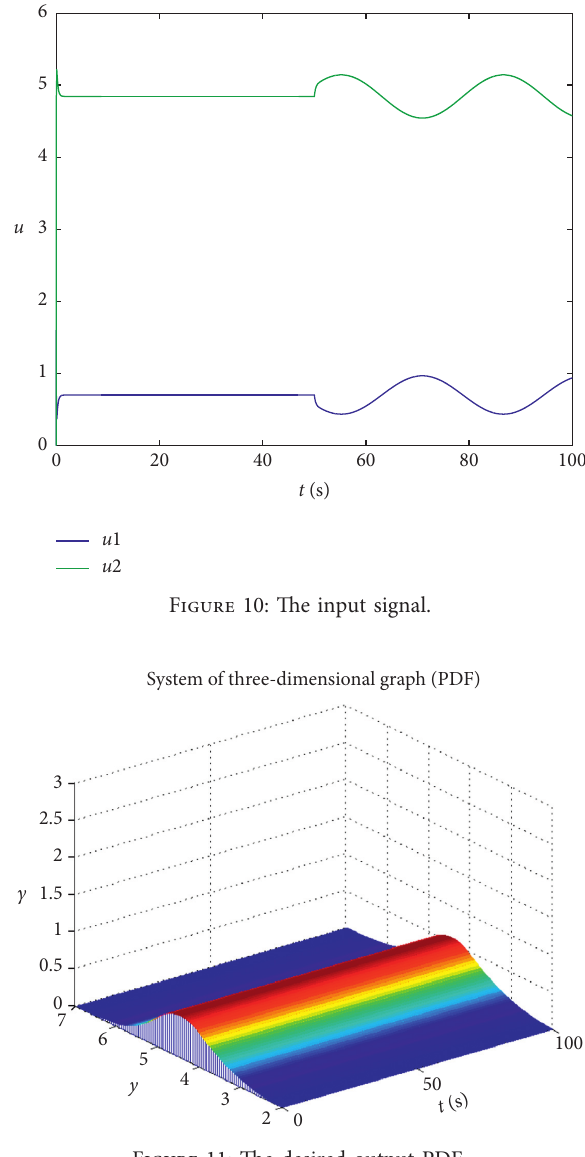
Figure 11: The desired output PDF.